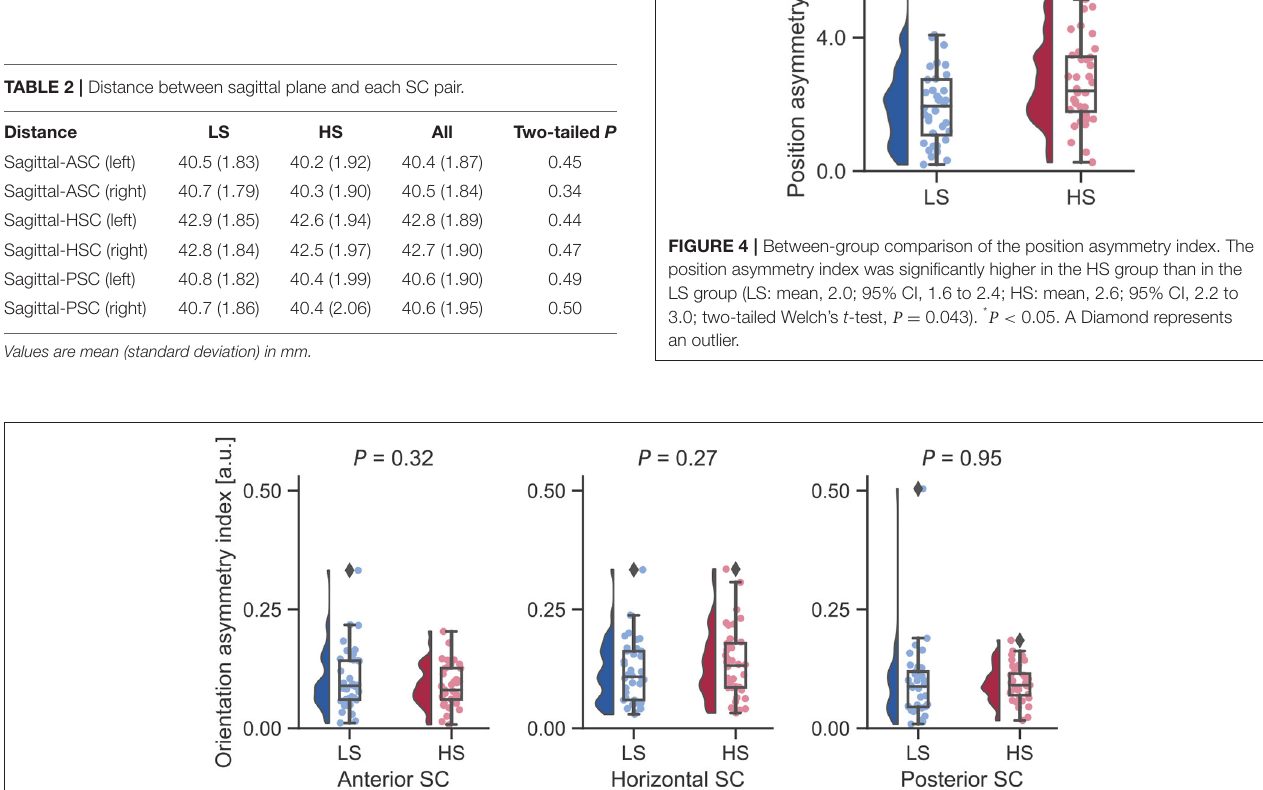
Frontiers in Neuroscience |